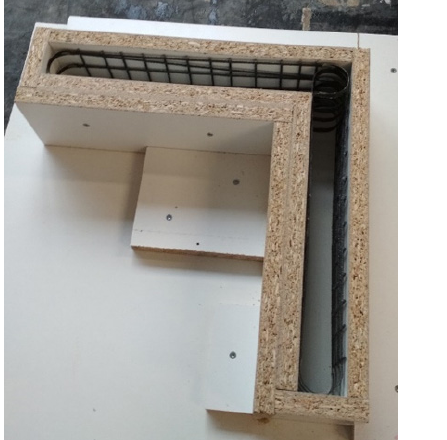
Figure 10. Rebar made of carbon roving ( a ) and detail presenting connection of rebars to form the reinforcement for the rigid frame ( b ).